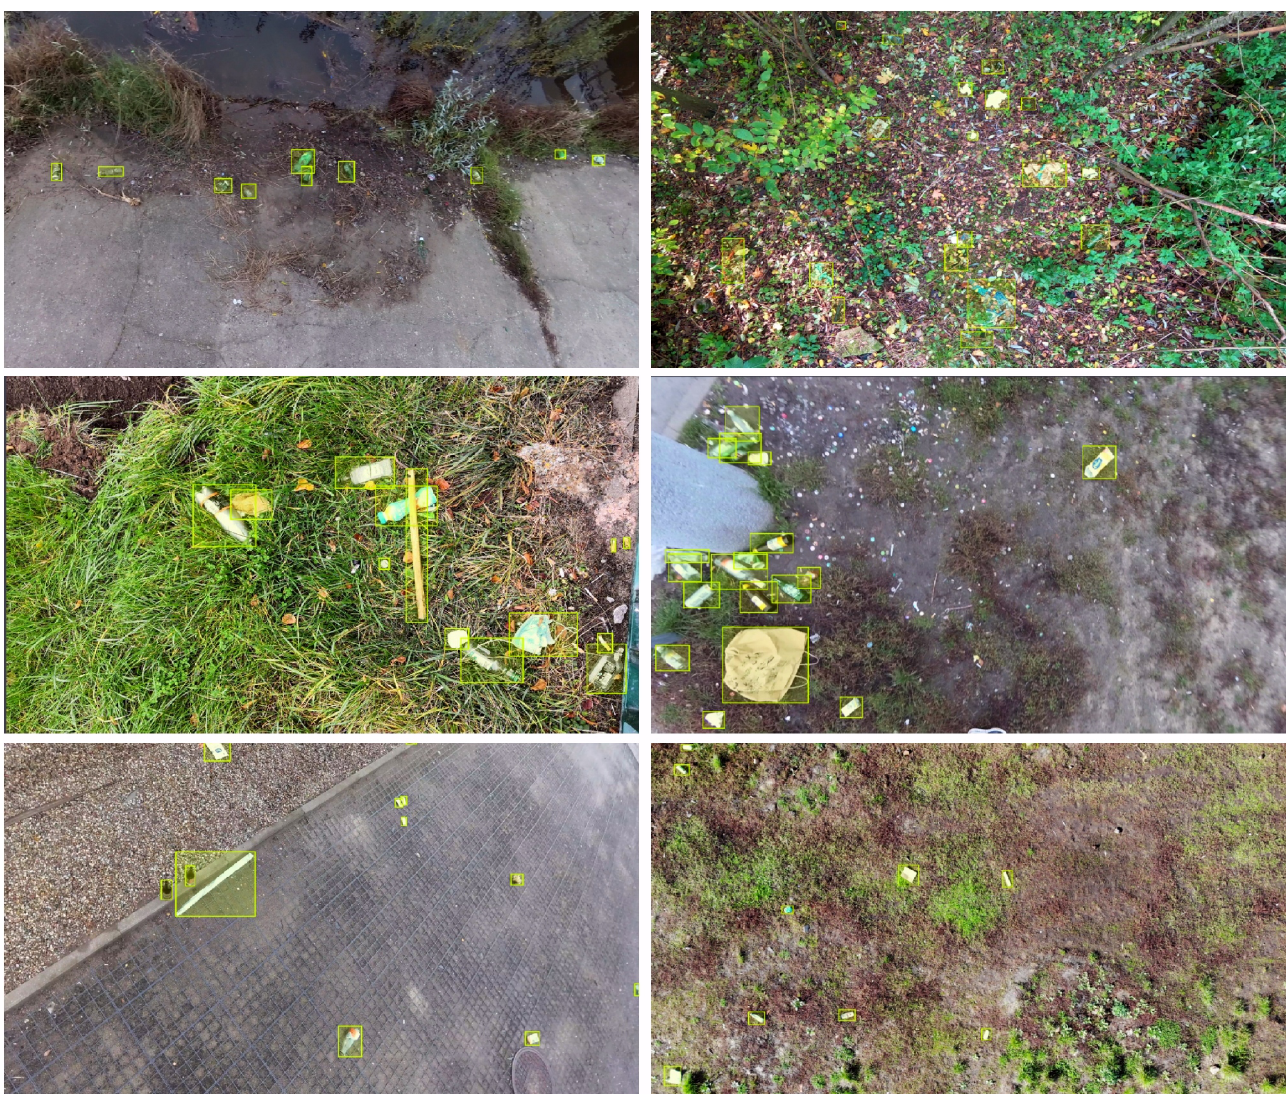
Figure 2. Sample images from the UAVVaster dataset with objects of interest highlighted. Please note the variability of backgrounds—both in terms of domain and in terms of the presence of disctractors, and the relatively small size of the objects to be detected.